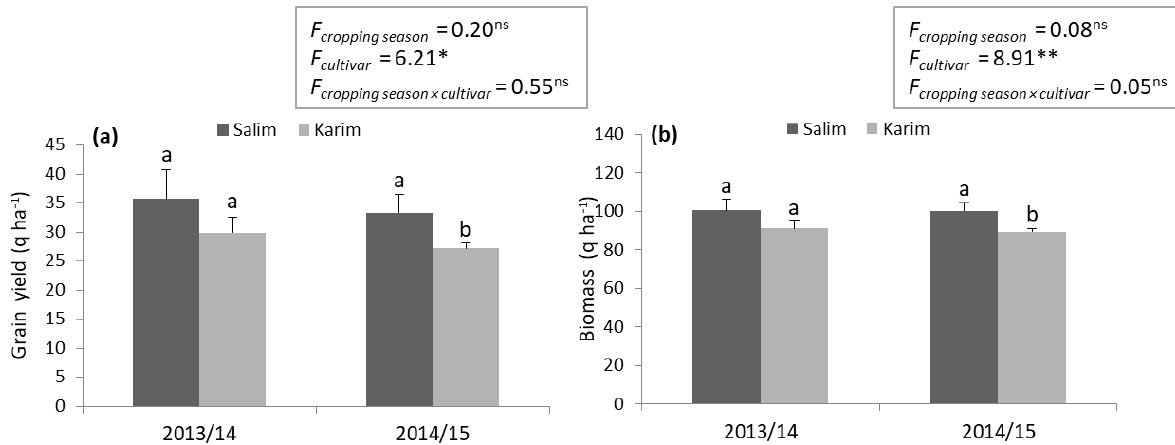
Figure 1. Effect of ‘Salim’ cultivar adoption based on mean grain yield ( a ) and biomass ( b ), compared to ‘Karim’ cultivar using the recommended technical package. Values represent the mean ± SD and different letters indicate significant differences between cultivars at p ≤ 0.05 (Tukey test) for each cropping season. F : F value; ns: non-significant; *: significant at the level 0.05; **: significant at the level 0.01.